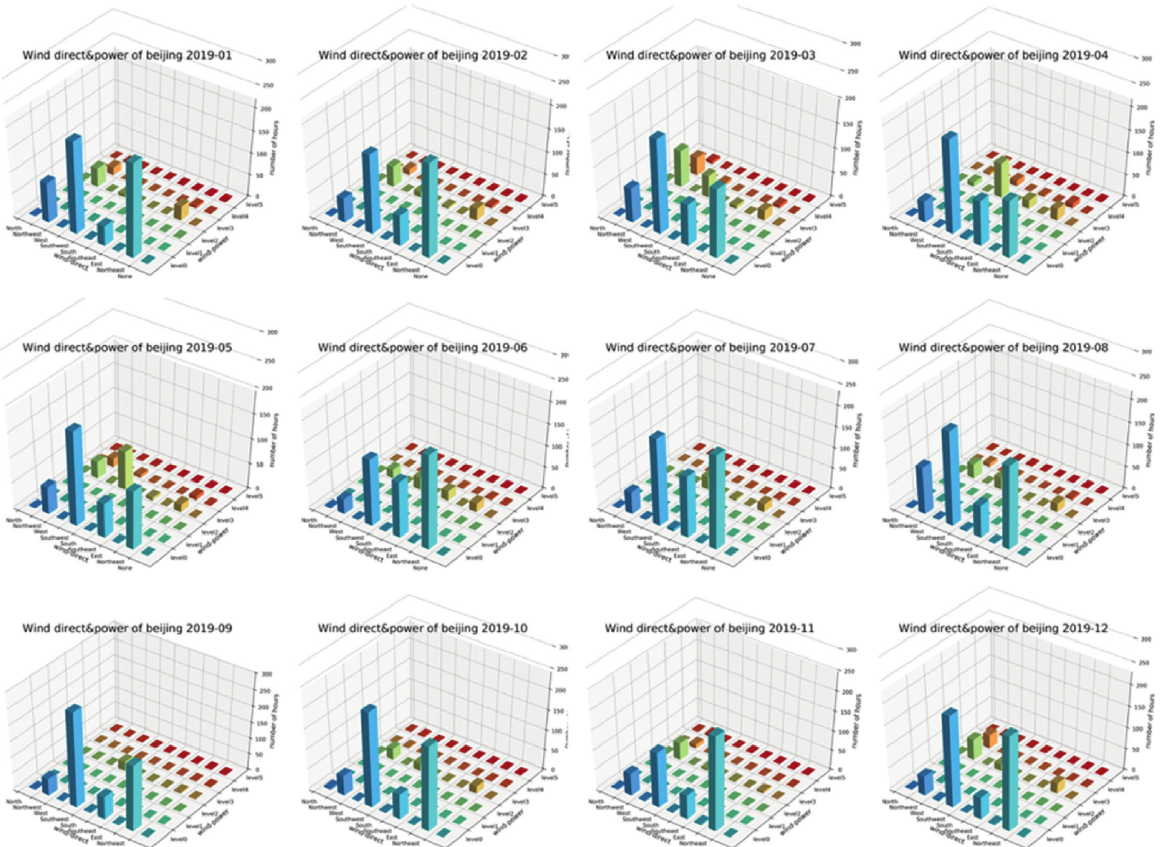
Figure 9: Comparison of the number of hours with different wind levels in different months of